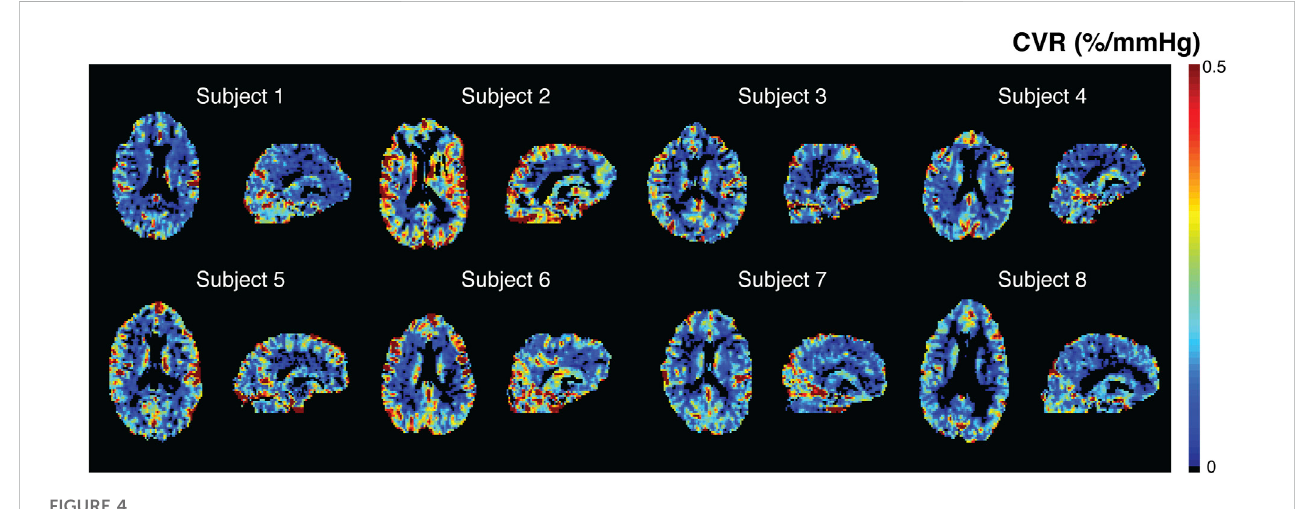
FIGURE 4 SineCO 2 CVR maps in individual